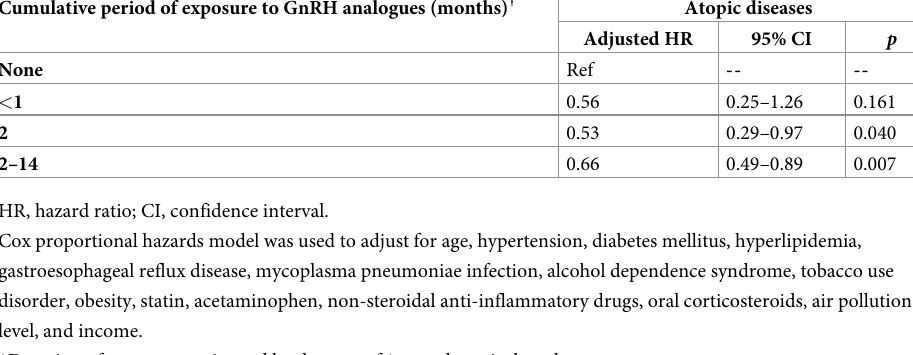
Table 4. Adjusted association between accumulative exposure time and atopic diseases among men receiving GnRH analogues. Cumulative period of exposure to GnRH analogues (months)